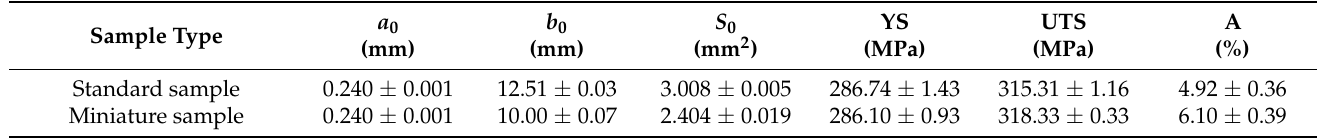
Table 2. Summary of the plastometric tests for the standard and miniaturized samples for the raw material. Sample